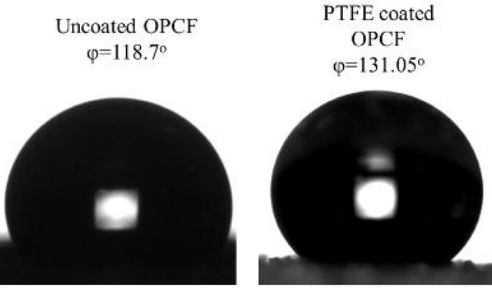
Figure 15. Water angles of uncoated and coated substrate [100].